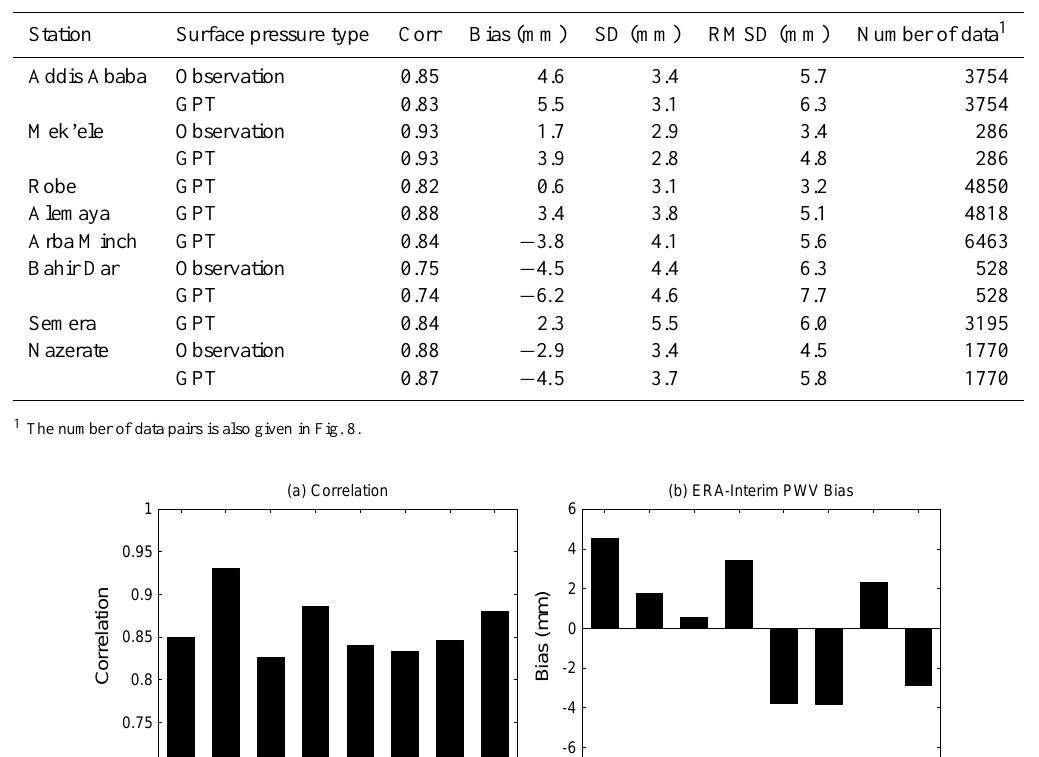
Table 5. Summary of correlation, bias, standard deviation and RMSD of ERA-Interim PWV with respect to GPS PWV and the number of data point pairs used in the evaluation of the statistics at the eight GPS stations.